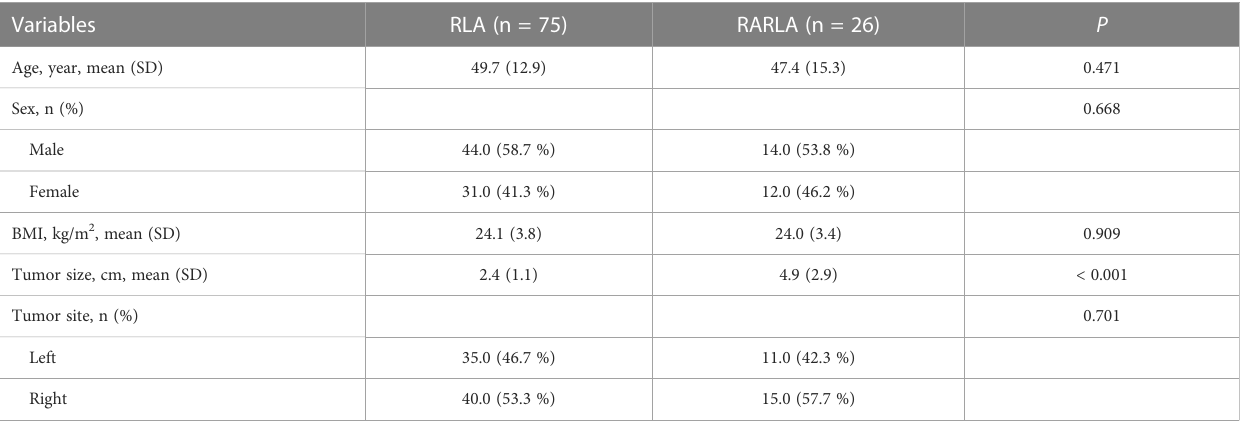
TABLE 1 Baseline demographical and clinicopathological characteristics of patients.